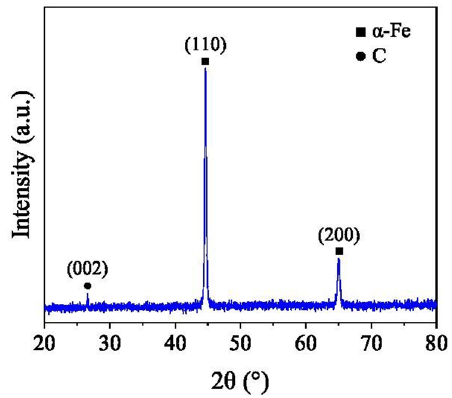
Figure 7. XRD pattern of Q195.